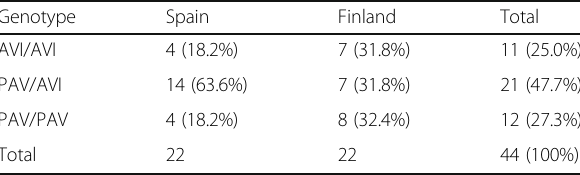
Table 1 Number of subjects in each genotype group from Spain and Finland Genotype